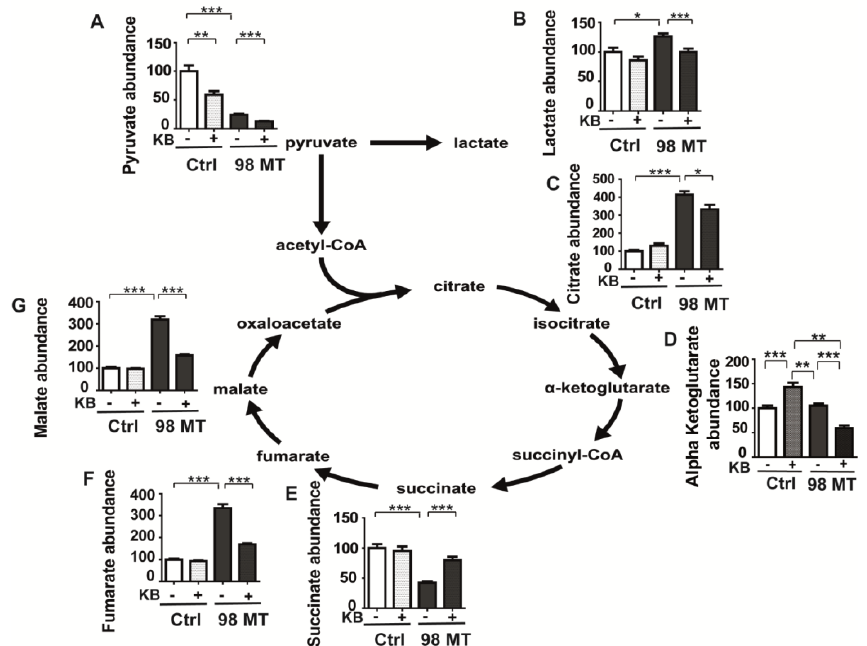
Figure 7. TCA cycle dysfunction in MELAS cells is alleviated by ketone bodies. ( A ) Pyruvate, ( B ) lactate, ( C ) citrate, ( D ) α KG , ( E ) succinate, ( F ) fumarate, and ( G ) malate levels in Ctrl and 98% MT cells treated for 48 h with (+, dotted line) or without ( − , colour bar) ketone bodies (KB). Results are presented as the mean ± SEM relative to Ctrl cells of at least 4 independent experiments. Statistical differences between 98% MT and Ctrl cells are indicated with an asterisk (* p < 0.05; ** p < 0.01; *** p < 0.001). Table 2. Mass spectrometry quantification of amino acids in post-mortem brain tissue from Ctrls and a patient with